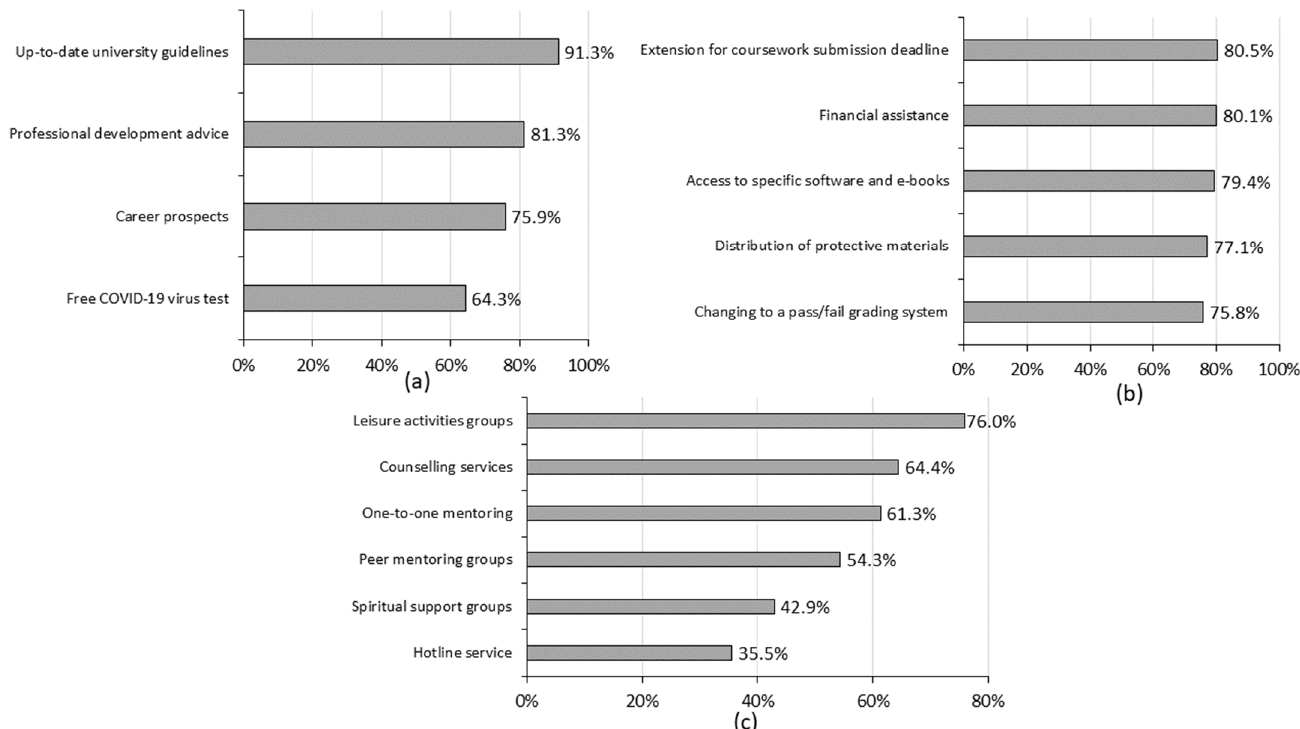
Figure 3. The perceived usefulness of support from universities. ( a ) Informational support; ( b ) in- strumental support; ( c ) emotional support.